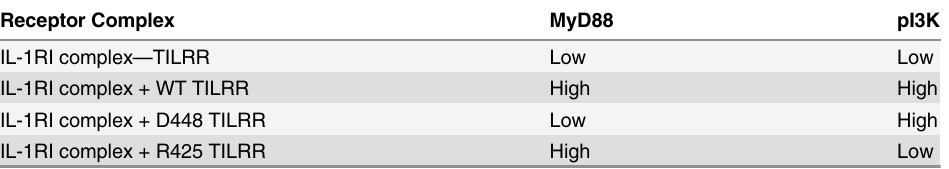
the biological system. In cases of varying affinity such as IL-1RI recruitment of MyD88, (Table 2) the radius was adjusted, as required, to reflect the change. 3D protein modelling and docking. The truncated tertiary structure of β -spectrin (NP_003119.2) was predicted using amino acid residues 27 – 749 from the N-terminal region to Table 2. Adapter-protein affinities for distinct IL-1RI complexes.